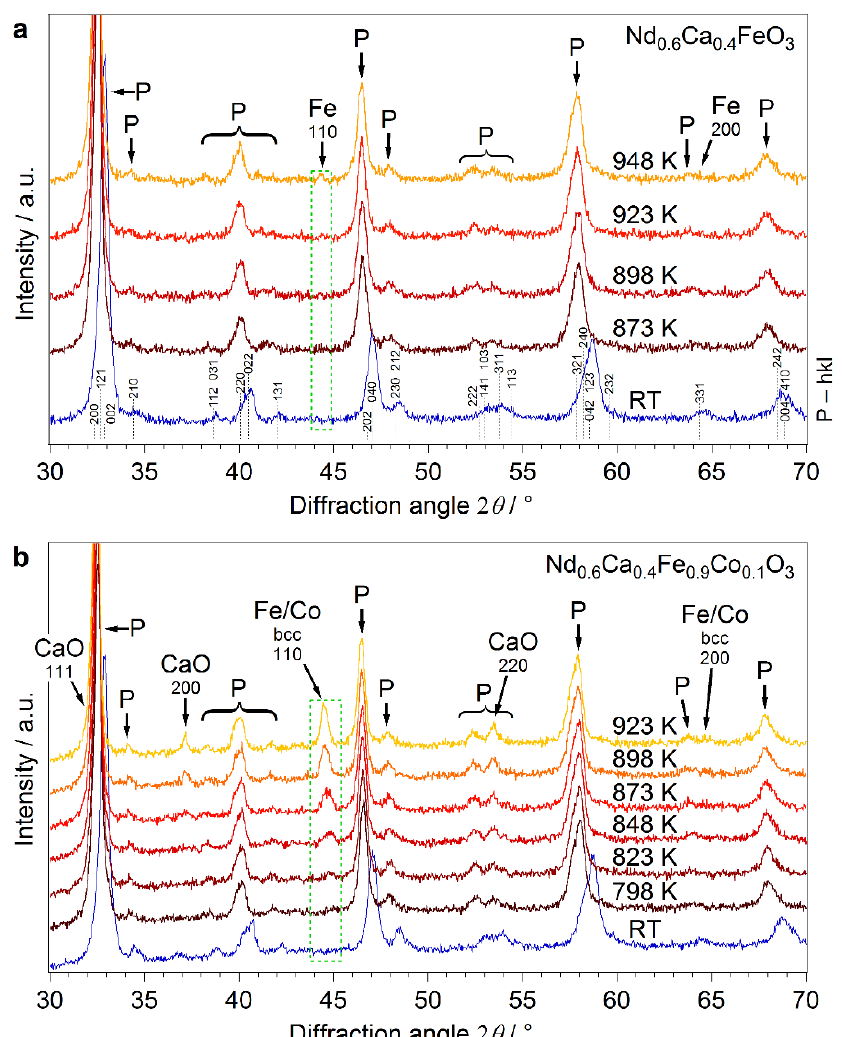
Figure 2. XRD patterns for ( a ) Nd 0.6 Ca 0.4 FeO 3- δ and ( b ) Nd 0.6 Ca 0.4 Fe 0.9 Co 0.1 O 3- δ . The hkl-indices of the undoped perovskite phase correspond also to the Co-doped material. The bottom diffractograms were collected at RT after oxidation in O 2 at 873 K. Patterns at elevated temperatures were collected in situ during reduction in humidified H 2 (ratio H 2 :H 2 O ≈ 32:1, p = 1 bar) at increasing temperature. For the undoped perovskite, Fe exsolution was observable at 923 K. The Co-doped material shows formation of a metallic bcc Fe/Co phase above 823 K.